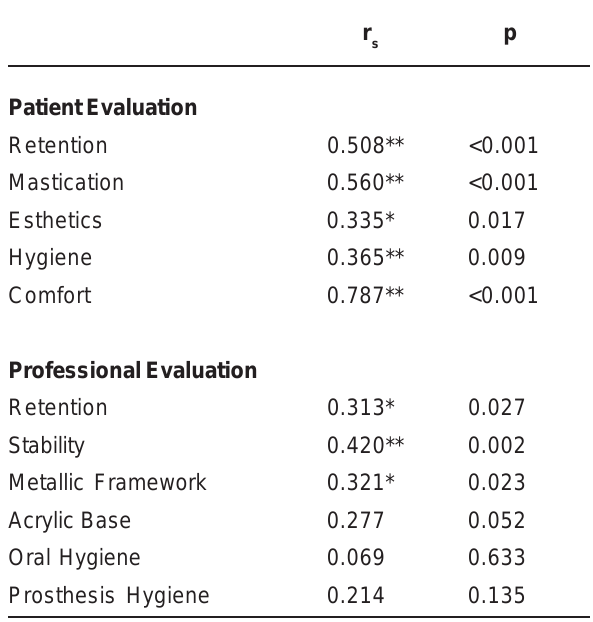
TABLE 4- Spearman’s coefficients of correlation (r between patient acceptance and other